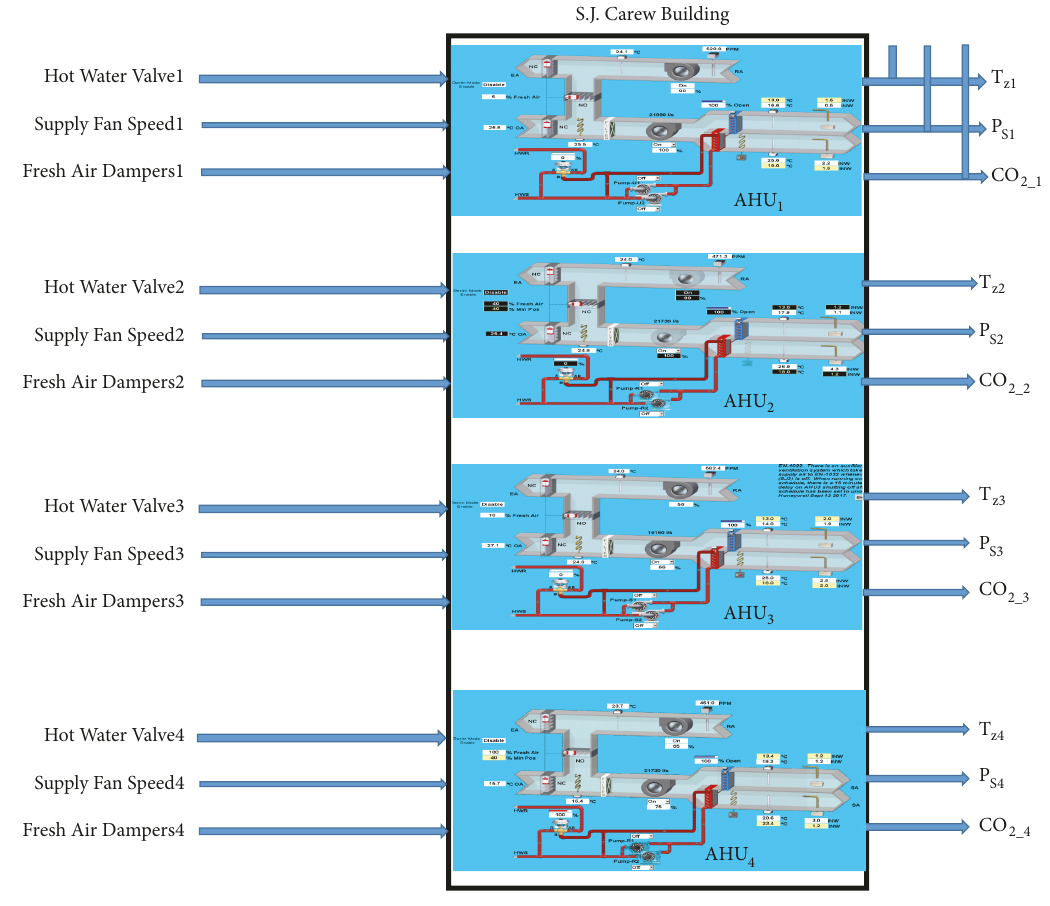
Figure 16: Inputs and outputs of the system.